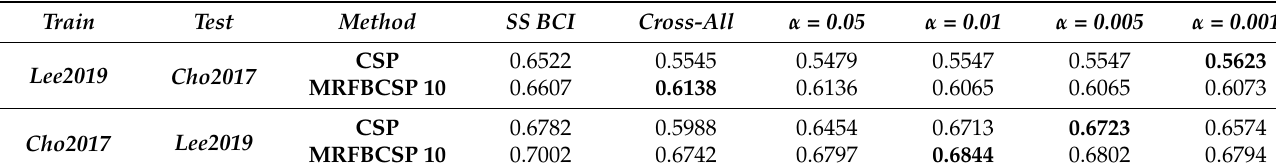
Table 3. Cross-dataset BCI performance.